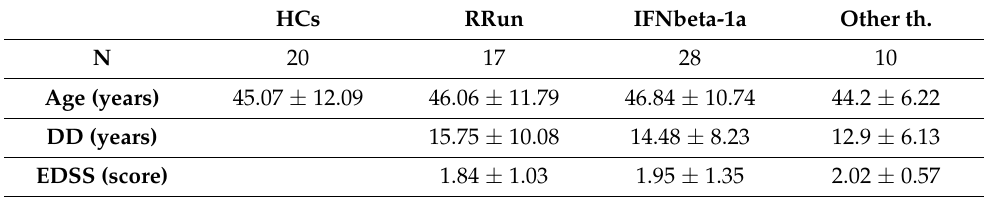
Table 1. Mean values are represented with standard deviations. HCs, healthy controls; RRun, relapsing remitting untreated MS patients; IFNbeta-1a, patients treated with IFNbeta-1a; other th., MS patients treated with other than IFN DMT; DD, disease duration; EDSS, Expanded Disability Status Scale. HCs RRun IFNbeta-1a other th.